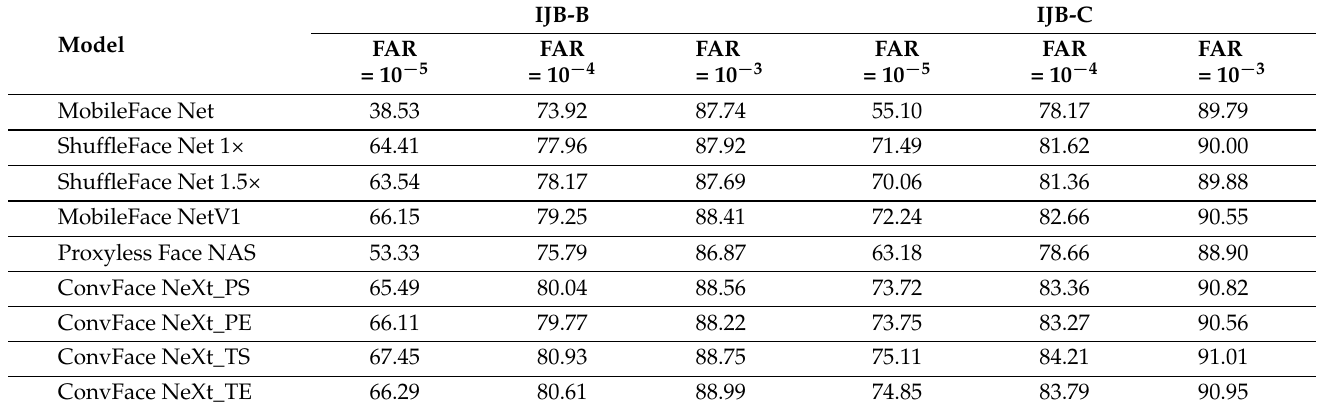
Table 11. Verification accuracy of different models on IJB-B and IJB-C